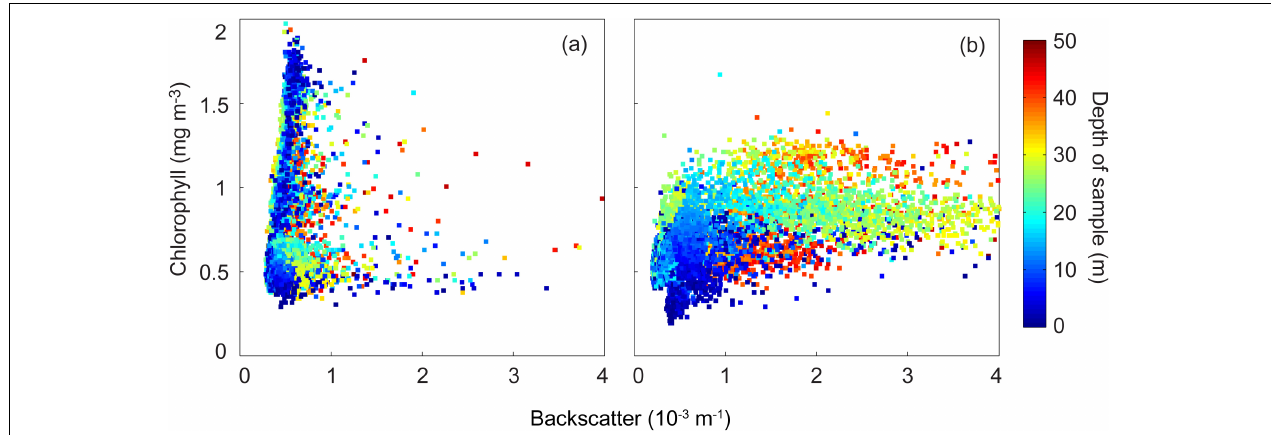
FIGURE 4 | Backscatter (m − 1 ) and chlorophyll (mg m − 3 ) scatter plot. (a) 14–16 March 2009; and (b) 21–23 March 2009.